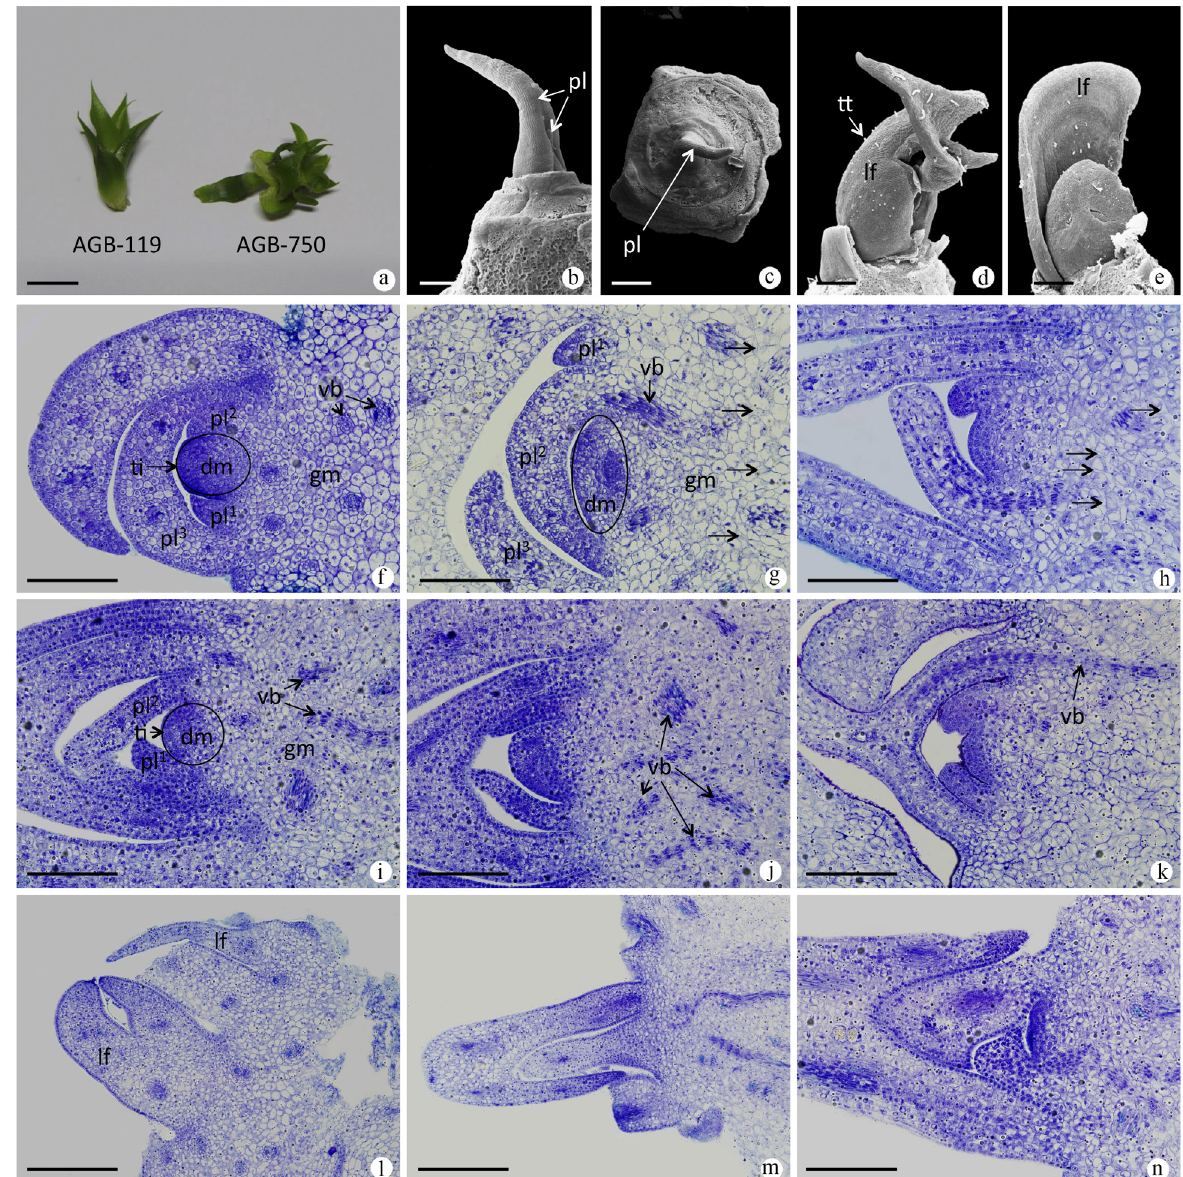
Figure 2. a) Pineapple plants after multiplication for 45 days in MS culture medium, showing ideal morphology (BGA-119) and unsuitable morphology (BGA-750) for excision of shoot tips b-e) Shoot tips observed by scanning electron microscopy. b, d, e) Shoot tips in transversal and c longitudinal views (BGA-119 and BGA-750) respectively. f-n) Shoot tips observed by light microscopy. f-h) Shoot tips of A. comosus var. comosus (BGA-009). i-k) A . comosus var. bracteatus (BGA-119) and (l-n) A. comosus var. erectifolius (BGA-750) after 30 days (f, i, l) 45 days (g, j, m) and 60 days (h, k, n) of multiplication in MS culture medium. dm = apical dome cells, gm = secondary shoot tip cells, pl = (1, 2 and 3) primordial leaves, tt = tector trichomes, vb = vascular bundles, ti = tunica. Arrows indicate large intracellular spaces. Bars: a = 1 cm, b-e = 200 µm, f-n = 100